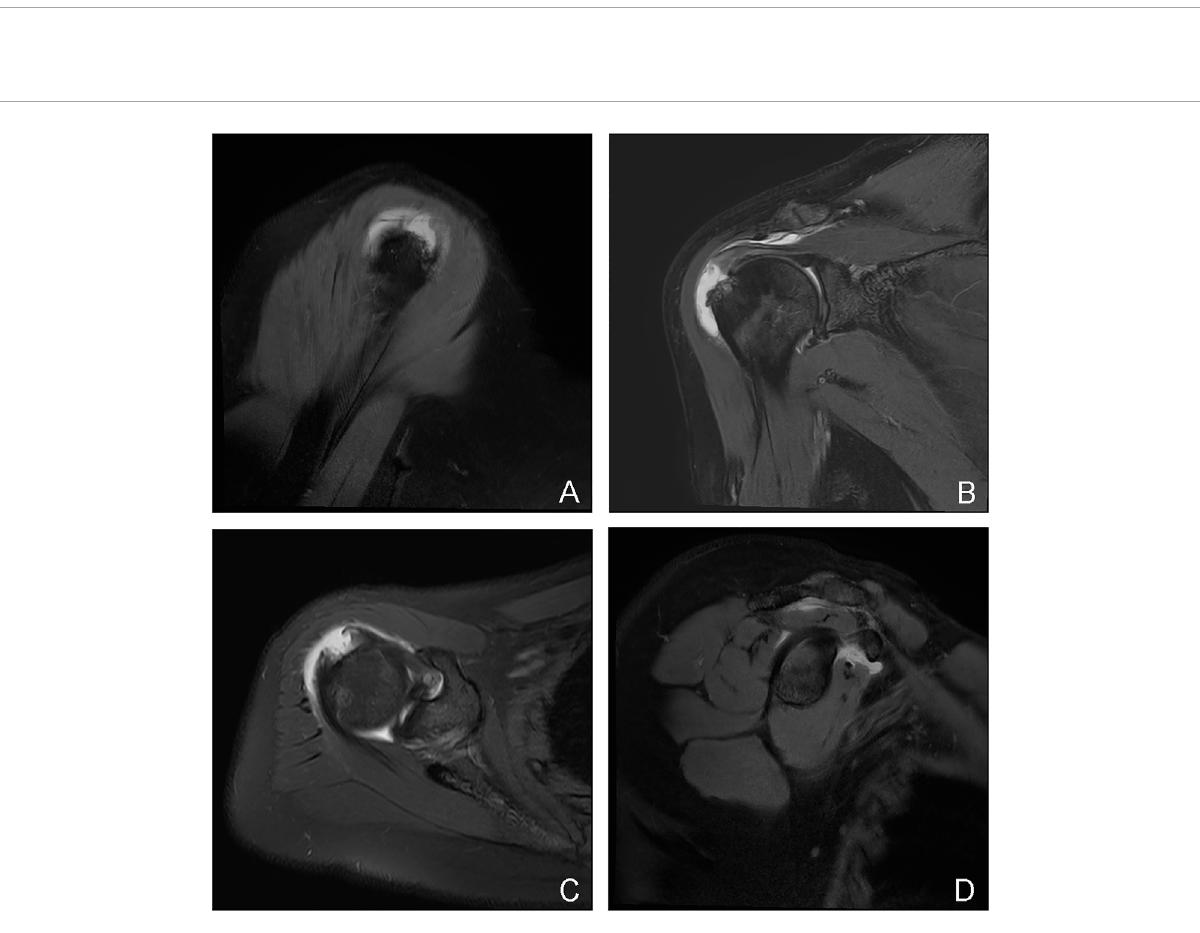
FIGURE 2 A typical case of a U-shaped tear: a 44-year-old woman with a localized full-thickness tear of the right shoulder, medial posterior to the supraspinatustubercleinsertion,witha “ U"-shapedchange (A – C) . (A) theobliquesagittal viewofT2lipid-suppressingsequence; (B) theaxialviewof proton density sequence; (C) the oblique coronal view of T2 lipid-suppressing sequence; (D) the oblique sagittal Y view of the rotator cuff from the T2 fat-suppressing sequence, showing mild atrophy of the supraspinatus and anterior infraspinatus with a little